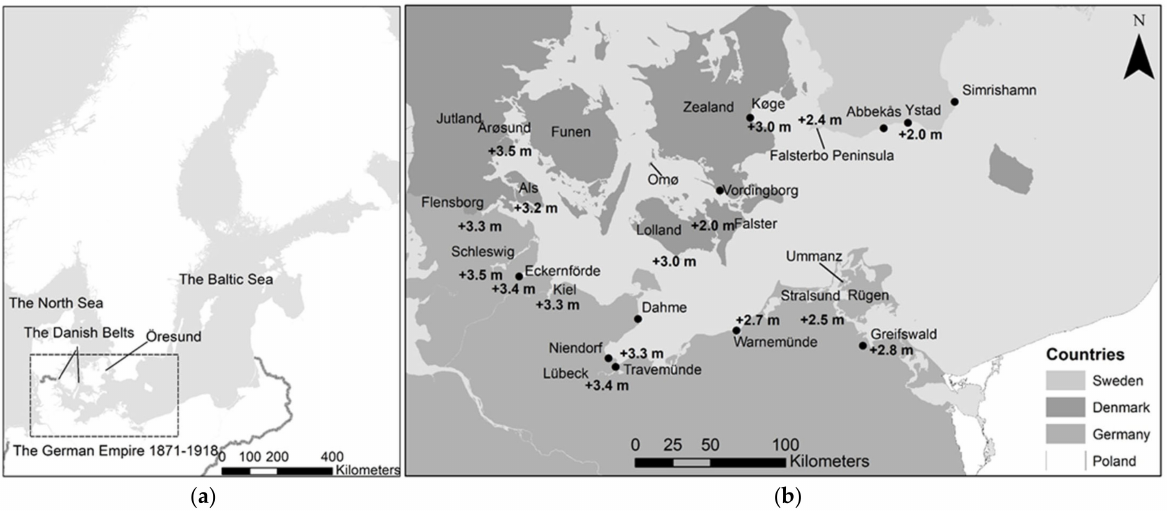
Figure 2. ( a ) Overview of the Baltic Sea basin. The land boundaries of the German Empire as in 1872 are indicated. ( b ) Overview of the affected area during the 1872 storm and the measured or reconstructed peak water levels along the